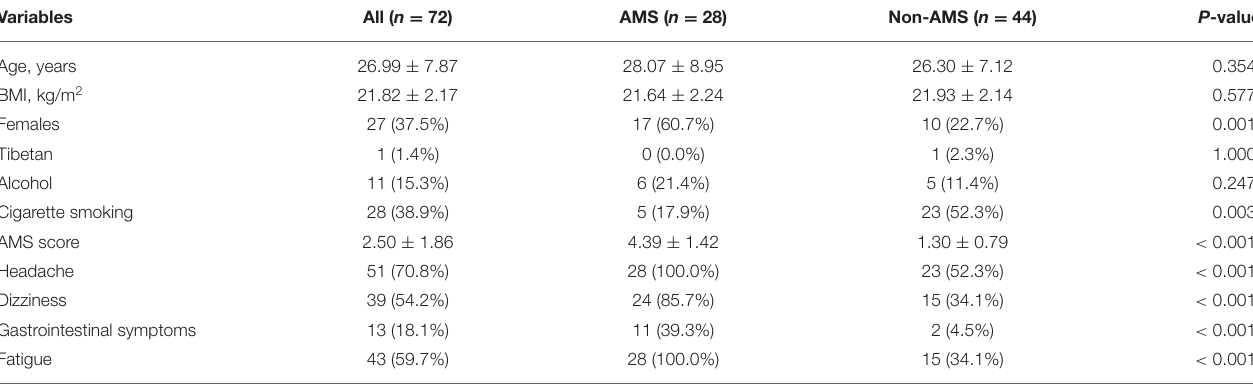
TABLE 1 | Demographic and AMS symptoms